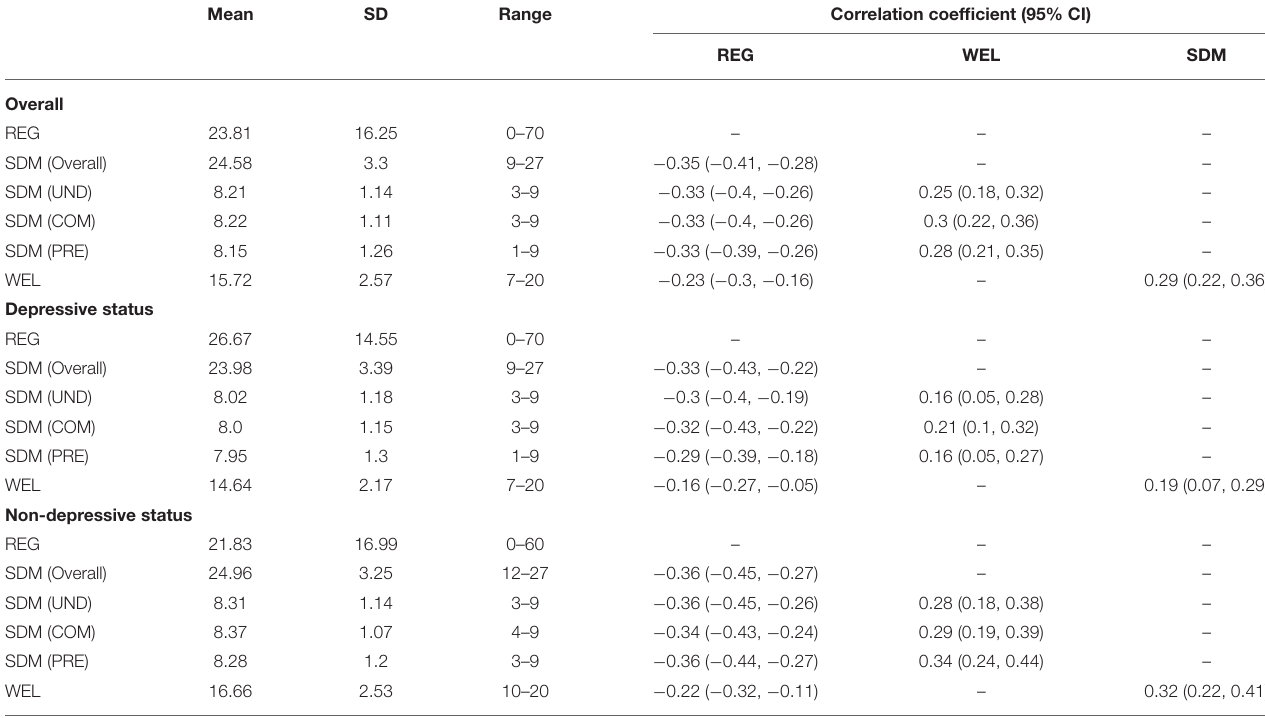
TABLE 2 | Descriptive statistics and correlation between measures. Mean SD Range Correlation coefficient (95%